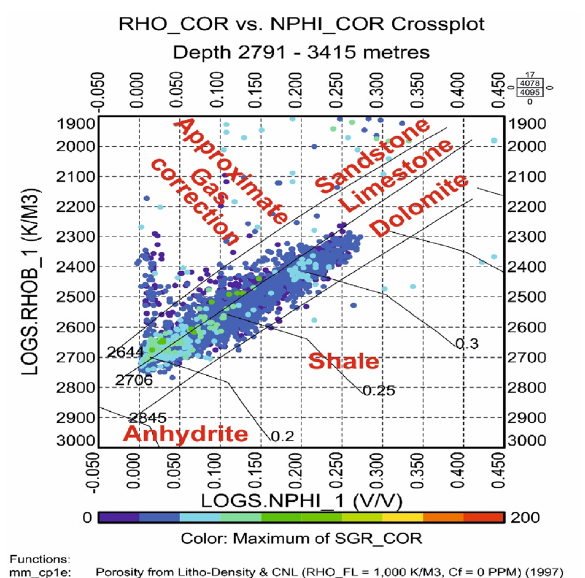
Fig. 2 Corrected neutron-density